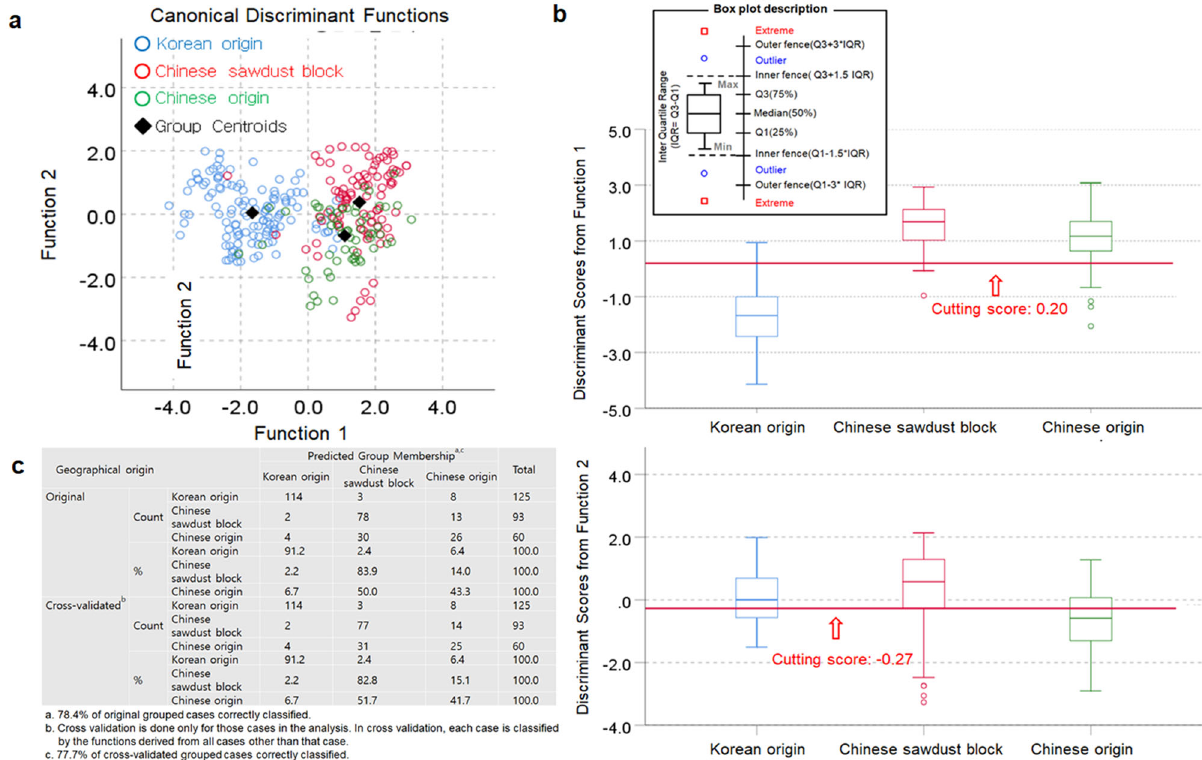
Fig. 3 Discriminant analysis of the geographical origin of shiitake mushrooms according to the sawdust block source (Korean origin, Chinese inoculated sawdust block, Chinese origin). a Discriminant model developed by δ 13 C, δ 15 N, δ 18 O, and δ 34 S in shiitake mushrooms, b Box-and-whisker plots for discriminant scores derived from the fi rst two canonical discriminant functions of the discriminant model developed for the geographical identi fi cation of shiitake mushrooms, and c Classi fi cation and cross-validated results of the origins of shiitake mushrooms produced by the different cultivation